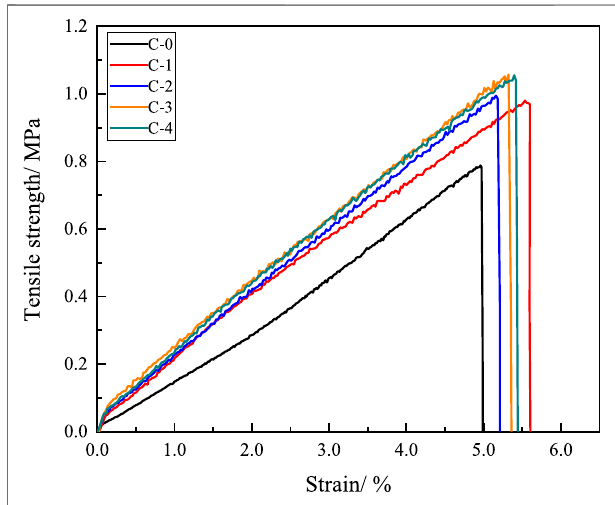
FIGURE 10 | Stress-strain curves of the tensile strength of the CTB and